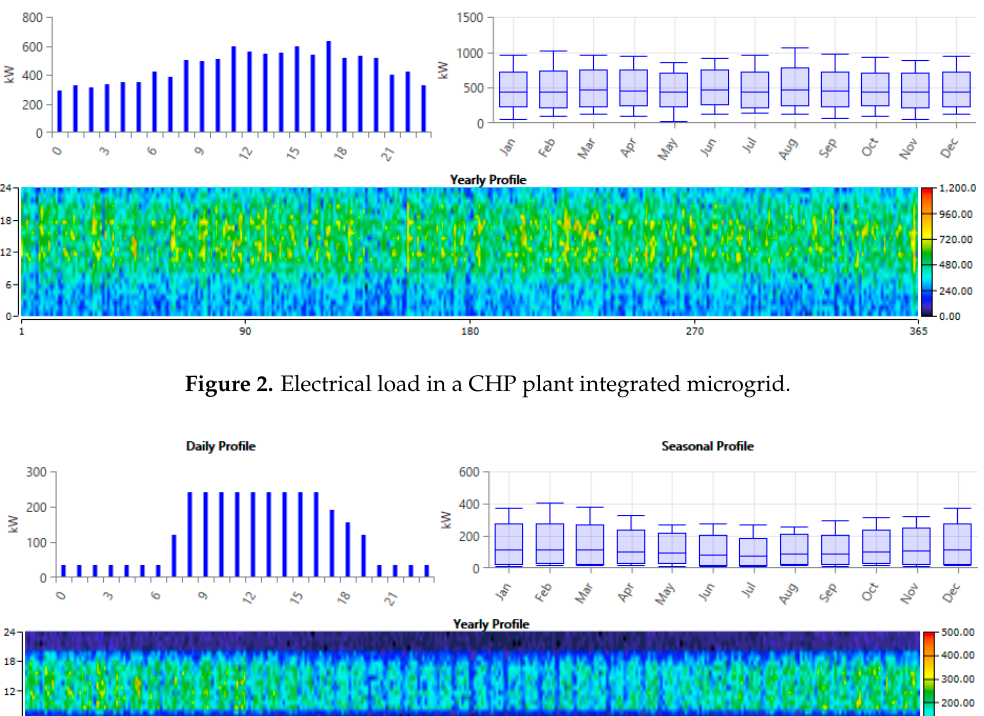
Figure 3. Thermal load in a CHP plant integrated microgrid.